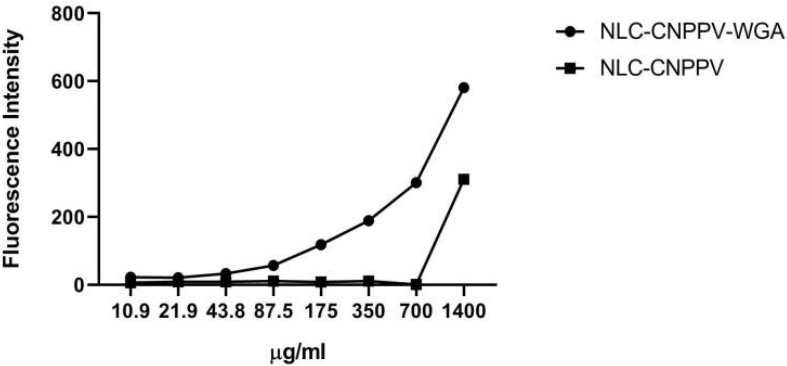
3.5. Internalization of the Particles Functionalized with WGA Lectin CN-PPV was used as a fluorescent marker to evaluate the phagocytosis capacity of the macrophages. The study compared the nanocarriers prepared using only PEG-660 stearate and functionalized with WGA lectin (Figure 2). The higher phagocytic activity was elucidated by the increase of the fluorescence per well. The nanocarriers functionalized with WGA showed higher phagocytic activity in a concentration-dependent manner.